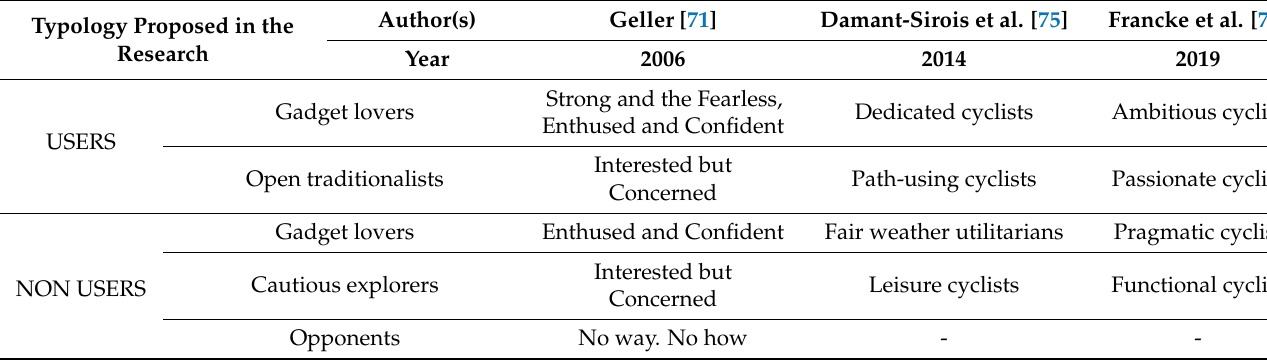
Table 2. Proposed typology against the background of other